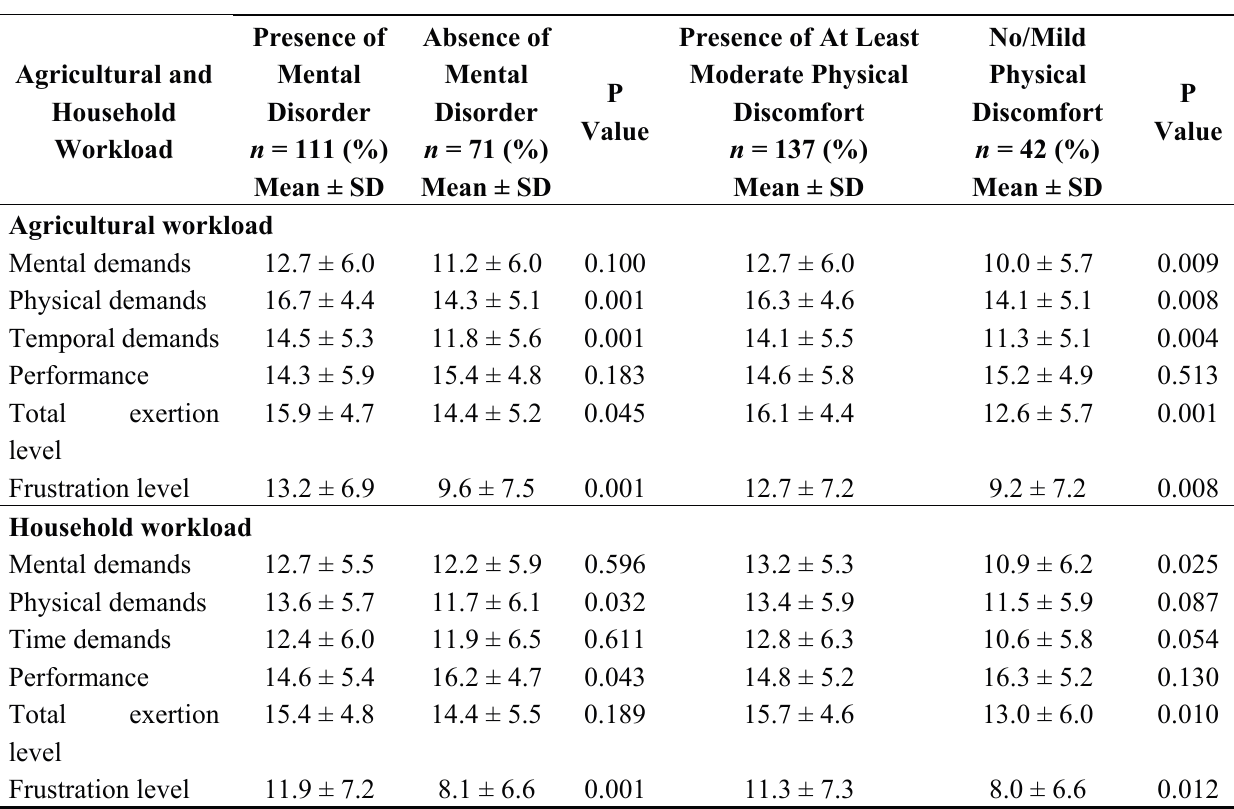
Table 1. Relationship of presence or absence of mental disorders and physical discomfort with household and agricultural workloads among female farm workers from the interior of the state of Rio Grande do Sul,